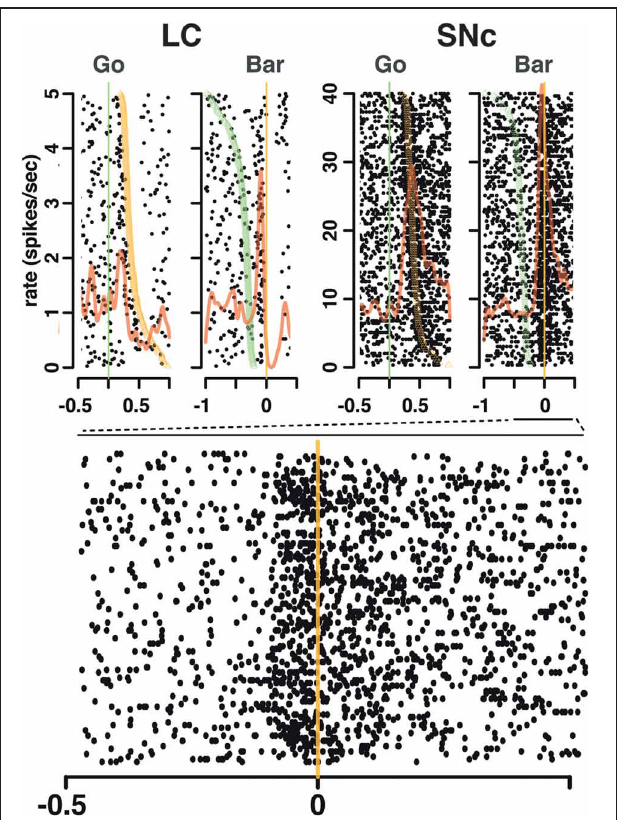
FIGURE 4 | Spike timing around the go signal and the go response. Neuronal activity of a representative SNc neuron (left) and a representative LC neuron (right). For each neuron, raster and spike density were generated with spikes aligned either on the onset of the go signal (green line, left) or the ensuing bar release (orange line, right). Trials are sorted by decreasing reaction time, with orange triangles representing the time bar release in each trial on the go signal-aligned activity and green triangles representing the go signal on the bar release aligned activity. For both the SNc and the LC, spikes fired between the go signal and the bar release were more closely related to the triggering of the action than to the onset of the